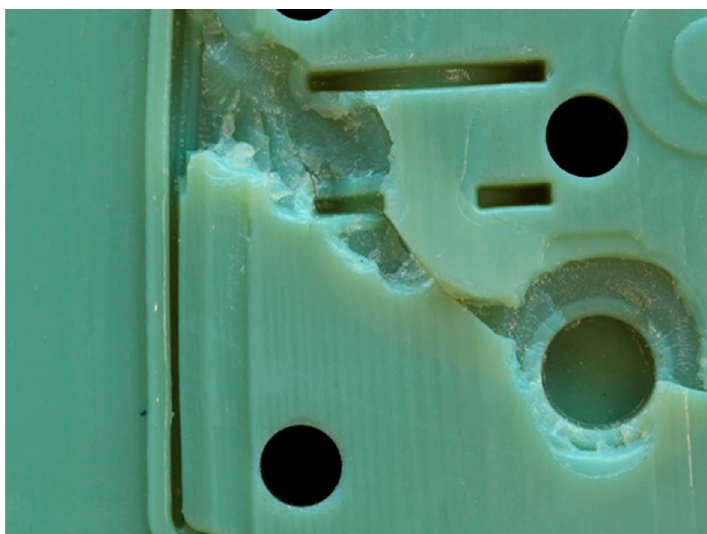
Figure 8. Avulsion failure region on the PRT insert from case study 2. This failure mode is characterized by progressive peeling of the substrate material. The image shows the catastrophic end-state of the process.